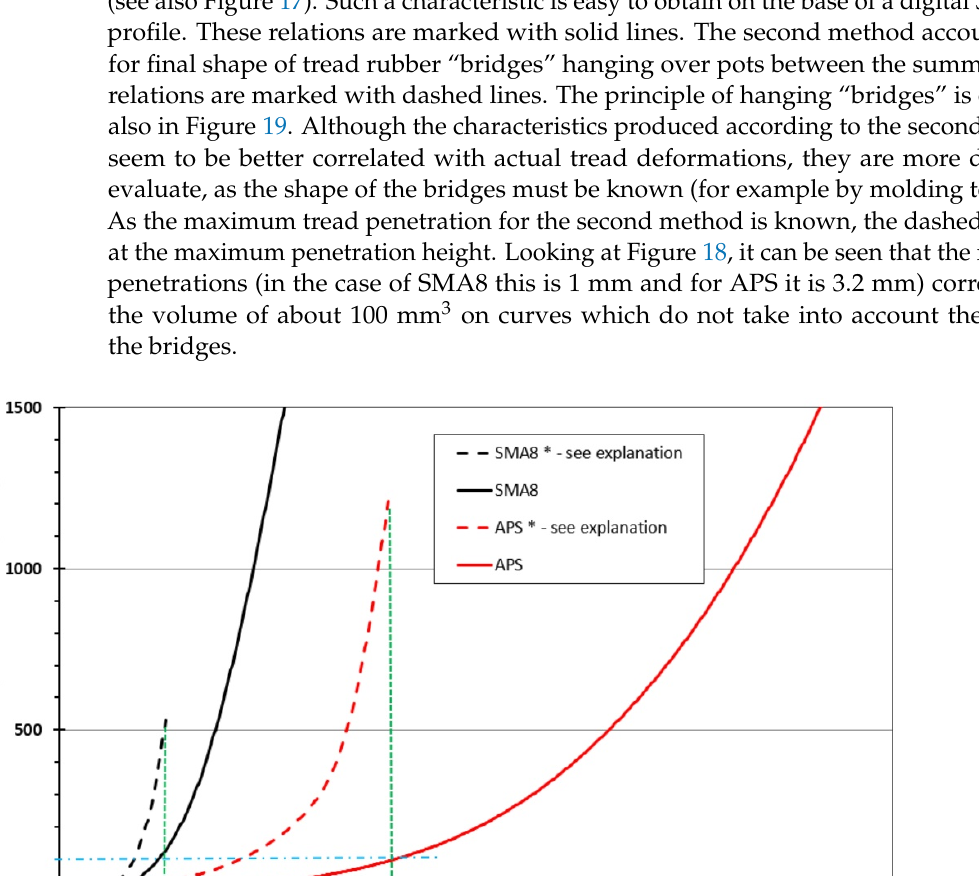
Figure 19. Relation between volume of deflected rubber and penetration depth for pavements SMA8 and APS. Author Contributions: Conceptualization, J.E. and S.S.; measurements, S.S.; validation, S.S.; formal analysis, S.S.; writing, J.E.; visualization, J.E.; supervision, J.E.; funding acquisition, J.E. Both authors have read and agreed to the published version of the manuscript. Funding: The research leading to these results has received funding from the Norway Grants 2014– 2021 via the Polish National Centre for Research and Development. Article has been prepared within the frame of the project: “Improvement of the EU tire labelling system for noise and rolling resistance”—NOR/POLNOR/ELANORE/0001/2019-00 which is co-financed by program “Applied research” under the Norwegian Financial Mechanisms 2014–2021 POLNOR 2019—Energy, transport and climate. Institutional Review Board Statement: Not applicable. Informed Consent Statement: Not applicable. Data Availability Statement: Data available on request. Acknowledgments: The authors would like to acknowledge Grzegorz Ronowski and Wojciech Owczarzak for their contribution to measurements and evaluations.